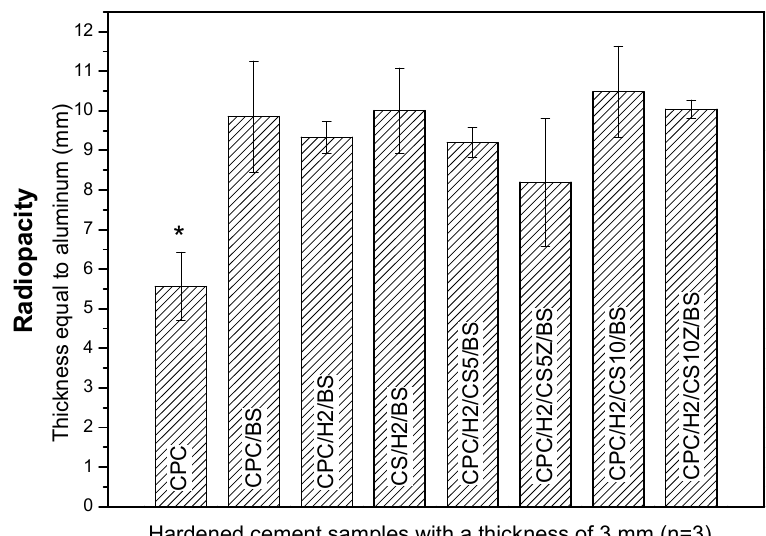
Figure 8. The relative cell viabilities (%) of CPC, CPC/H2, CPC/H2/CS5, CPC/H2/CS5Z, CPC/H2/CS10 and CPC/H2/CS10Z compare with HDPE (positive control group), DMSO (negative control group), and a blank group (as 100% cell viability) obtained in 24 h cultures. The data in the same statistical level was marked with the same letter (a, b, c, d, and e) on the bar.